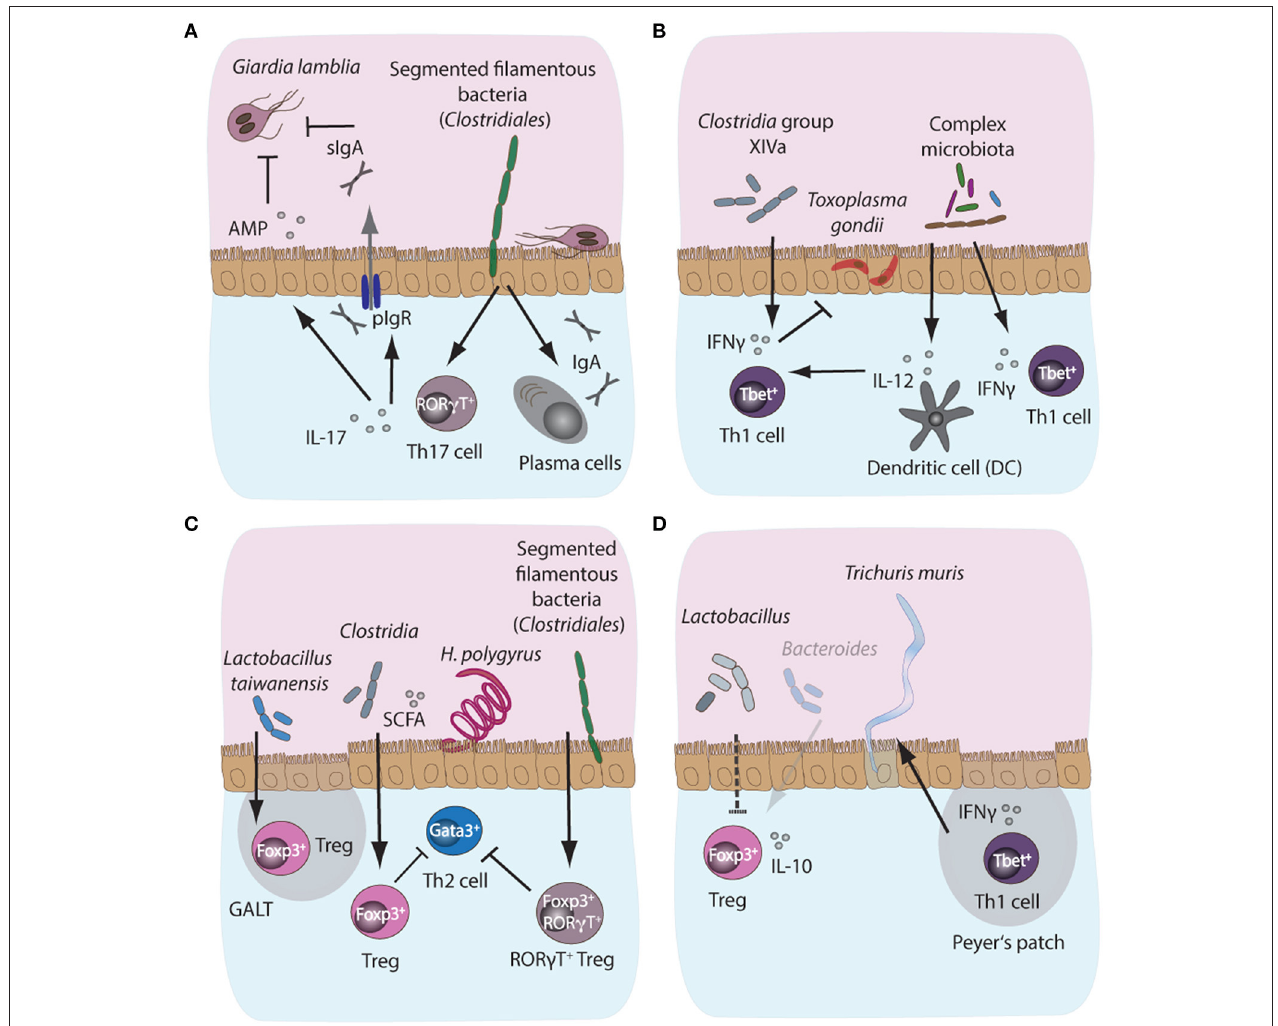
FIGURE 3 | Microbiota-dependent host immune responses during intestinal parasite infections in mice. (A) Segmented filamentous bacteria (SFB), members of the Clostridiales bacterial group colonizing the small intestinal tract of mammals, are potent inducers of intestinal IgA and Th17 responses in mice. Importantly, both IgA and Th17 responses are key host protective immune mechanisms against the protozoan parasite Giardia lamblia . IgA can directly target trophozoites, while IL-17A supports polymeric Ig receptor expression and hence IgA transport into the lumen, in addition to promoting antimicrobial peptide (AMP) secretion by epithelial cells. Resistance phenotypes to giardiasis have previously been linked to the presence or absence of SFB, suggesting a potential correlation between microbiota-induced intestinal IgA and Th17 responses and control of infection with Giardia . (B) During acute murine infection with Toxoplasma gondii , the presence of complex intestinal microbiota leads to MyD88-dependent signaling, triggering protective IL-12 responses in intestinal dendritic cells. (C) During infection with the small intestinal nematode Heligmosomoides polygyrus , the increased abundance of Lactobacilli and Clostridiales producing short chain fatty acids (SCFA)have been shown to